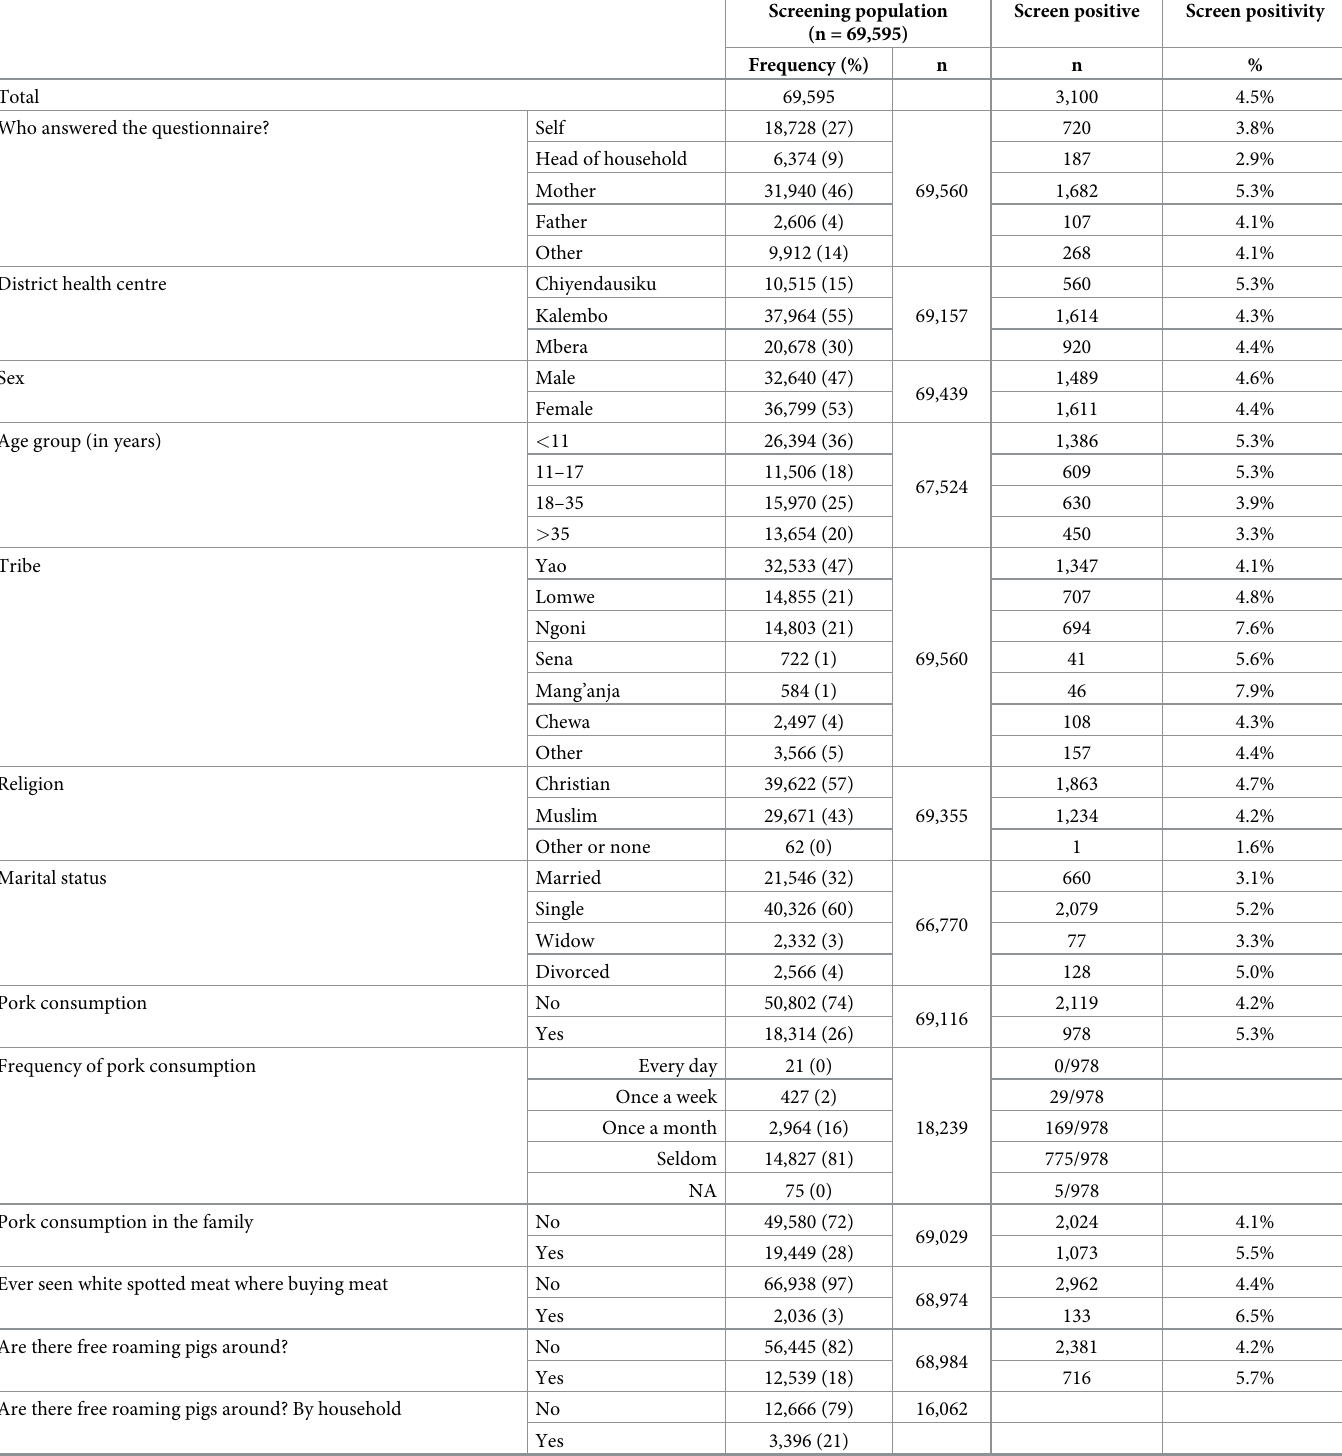
Table 1. Baseline and demographic characteristics according to the result of the screening questionnaire used in a cross-sectional study conducted among a rural population of the Balaka district of Malawi, October to December